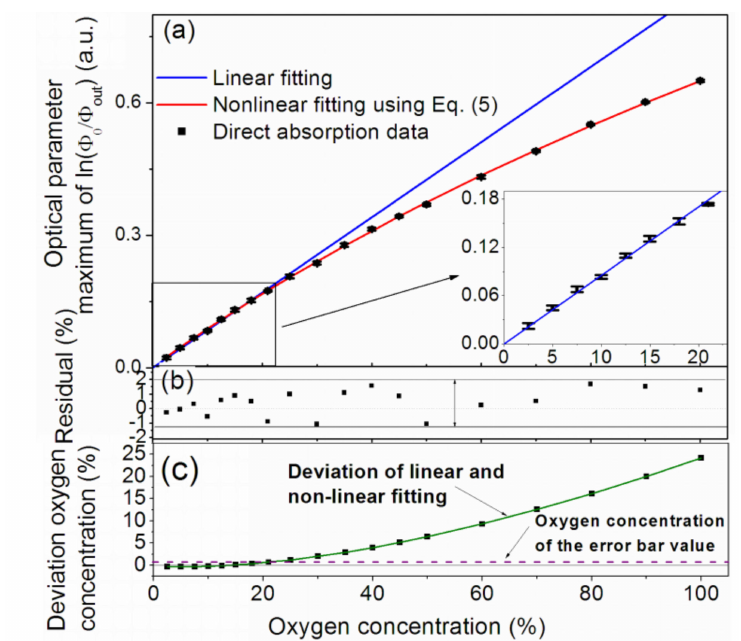
Figure 5. ( a ) Relationship between the OP and oxygen concentration; the inset shows an enlarged view of the low concentration range. ( b ) Residual error between the experimental data and the non-linear fitting result. ( c ) Deviation between the linear and non-linear fitting